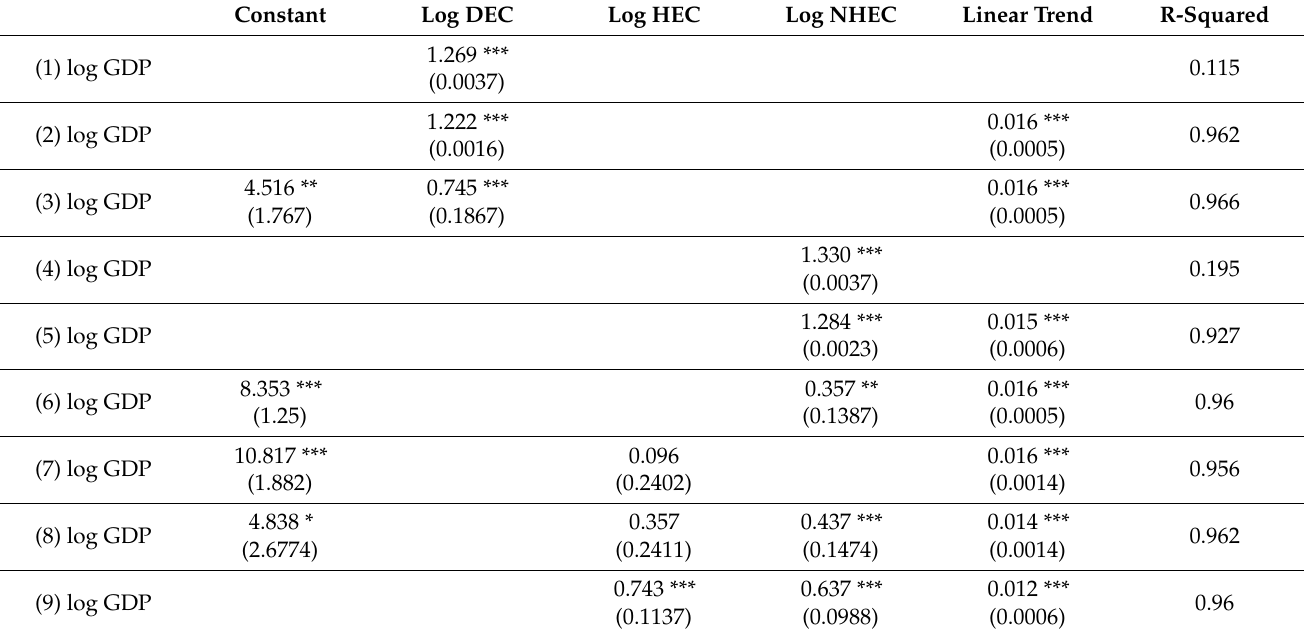
Table 6. GDP, domestic, household, and non-household electricity consumption.